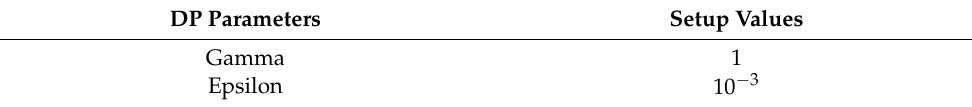
Table 6. Dynamic Programming parameters setup values.